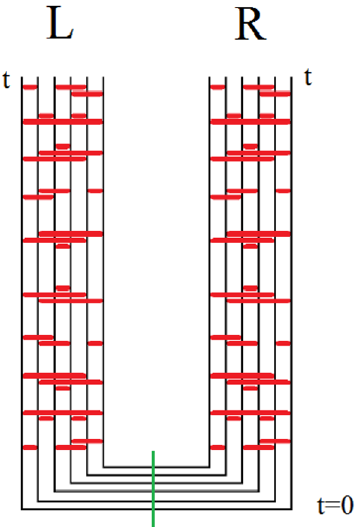
Figure 1 . A quantum circuit representing the time evolution of thermo(cid:12)eld double. Figure 15: Quantum circuit modeling the evolution of the TFD state. The initial state is a product of Bell pairs shared between the left and right sides. Each side evolves independently of the other.